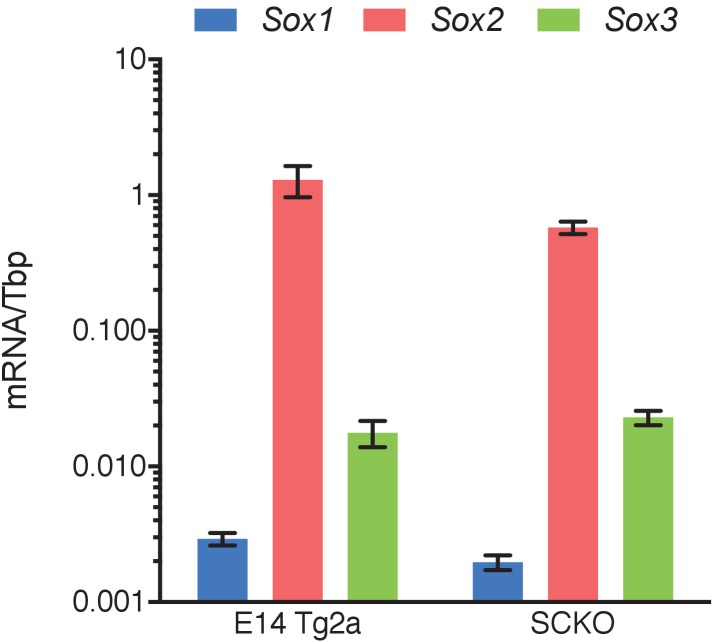
RT-qPCR analysis of the indicated transcripts in E14Tg2a and SCKO ESCs.mRNA levels were normalised over Tbp. Error bars represent standard error of the mean (n = 3).